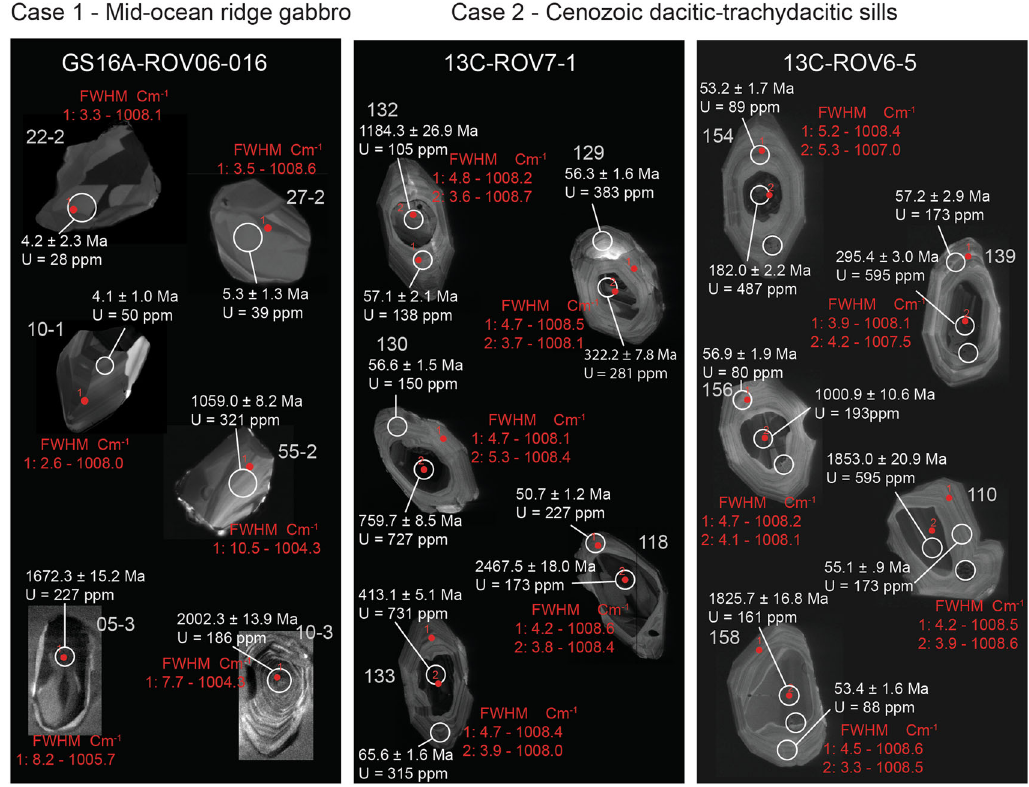
Fig. 2 Representative cathodoluminescence images of zircon grains. White circles correspond to 26 µ m laser-ablation spots. Circles that have no associated value are analyses that are not reported or used in this